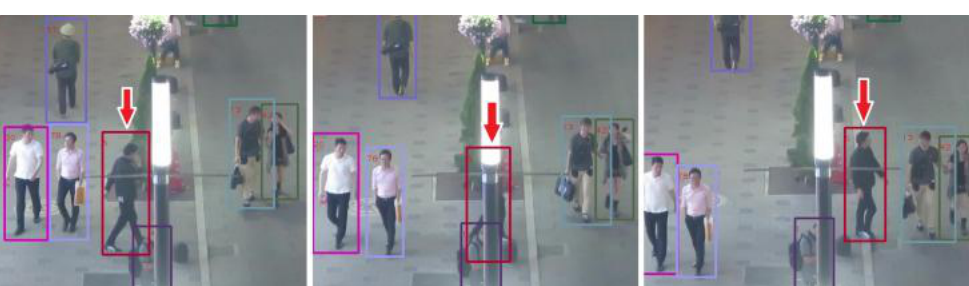
Table 2. The relationship between occlusion and IDs. Nocc1–3 represent IDs number of the three image sets, respectively.